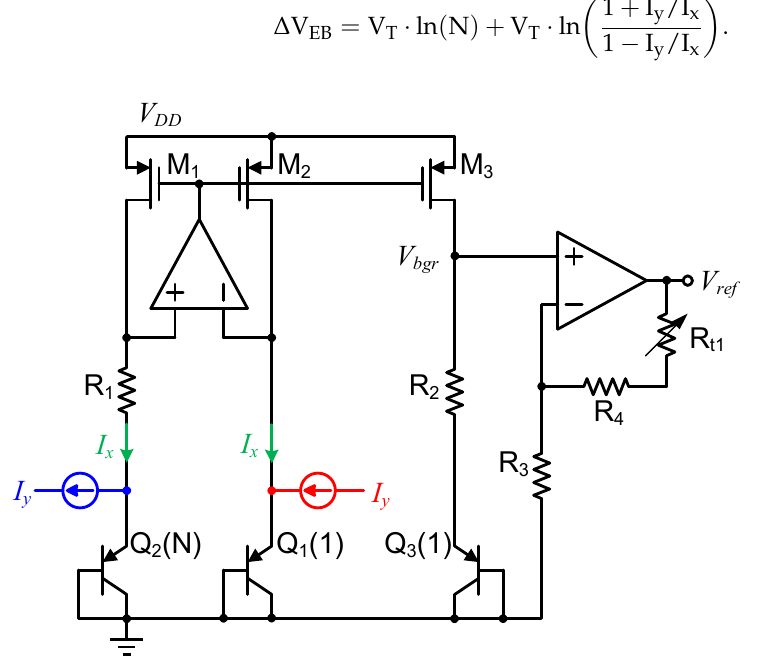
Figure 4. Principle of the proposed curvature compensation BGR.